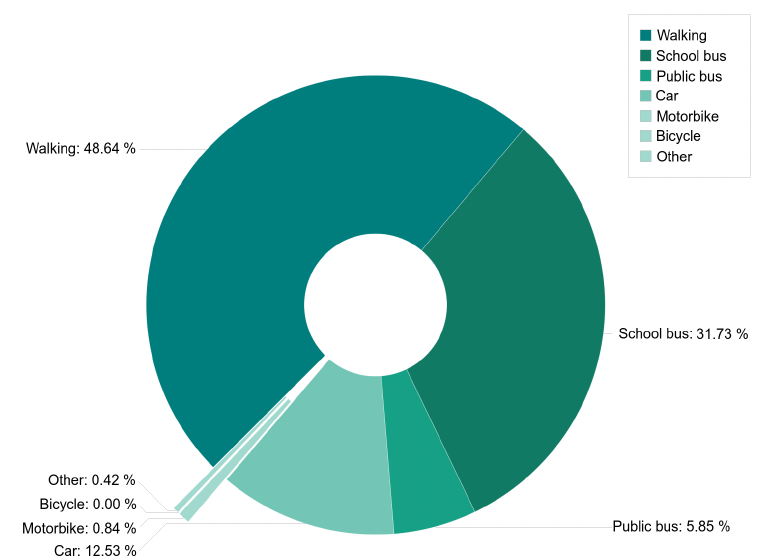
Figure 5. Means of transportation used by students who usually go to school alone (453 students out of the 1883 total respondents), on the day of the